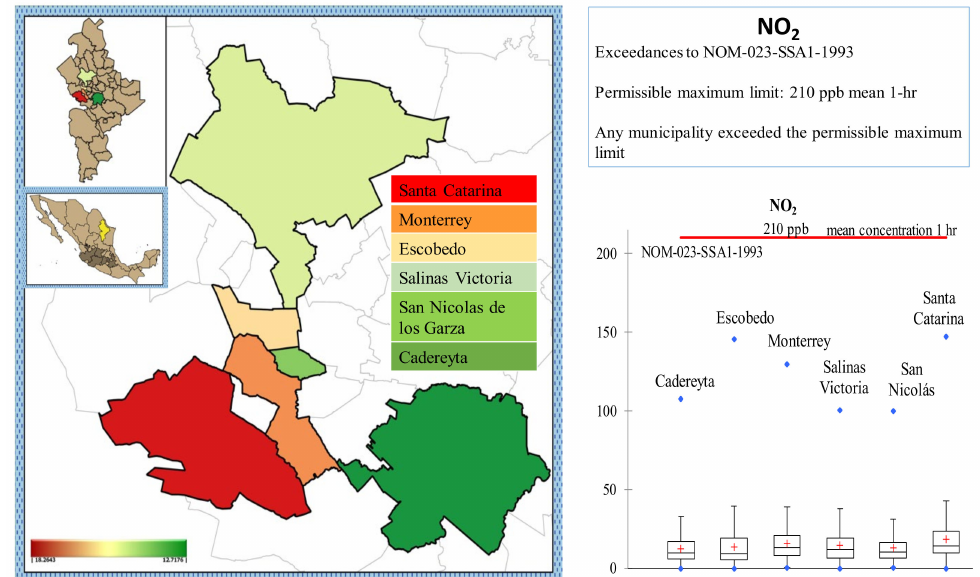
Figure 2. Mean concentrations of NO 2 in MAM during